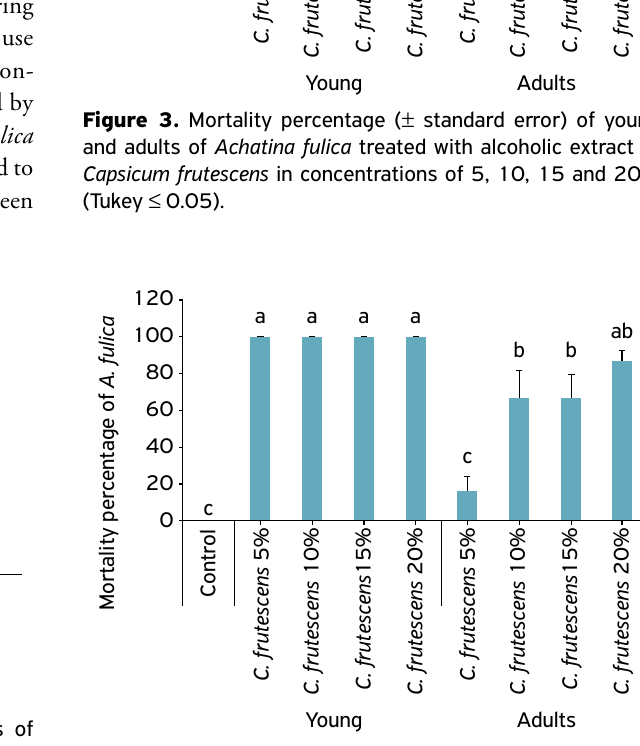
Figure 4. Mortality ( ± standard error) of Achatina fulica in two periods of exposure to alcoholic extract of Capsicum frutescens